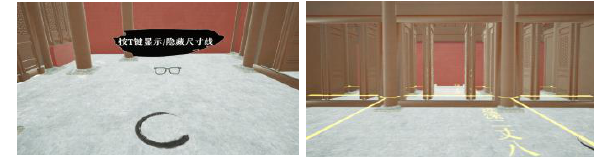
Figure 18. The glasses in the temple Figure 19. Hidden pattern of Yangshi Lei Archives